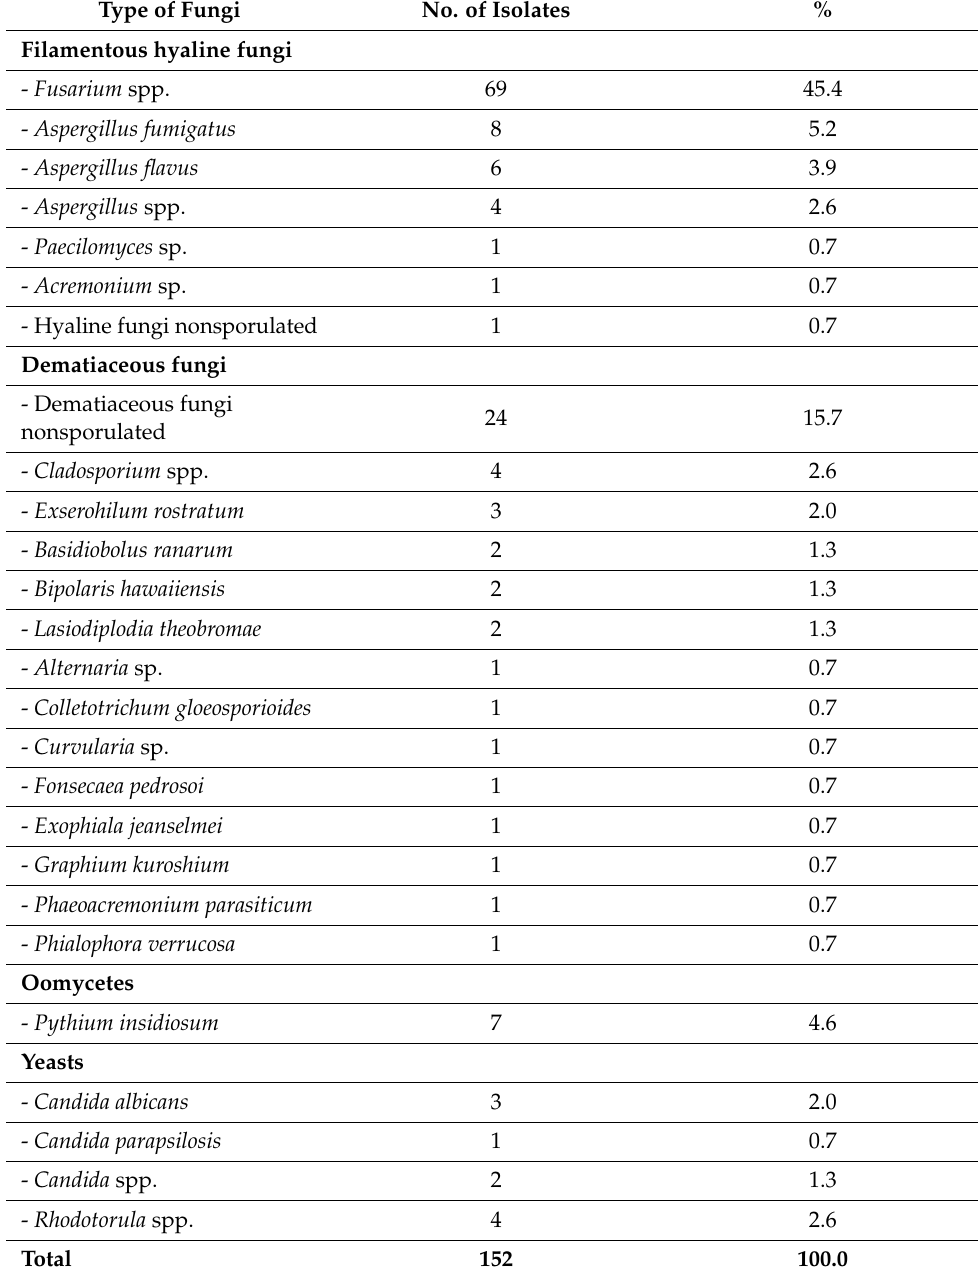
Table 2. Spectrum of fungal agents isolated during the study period of fungal